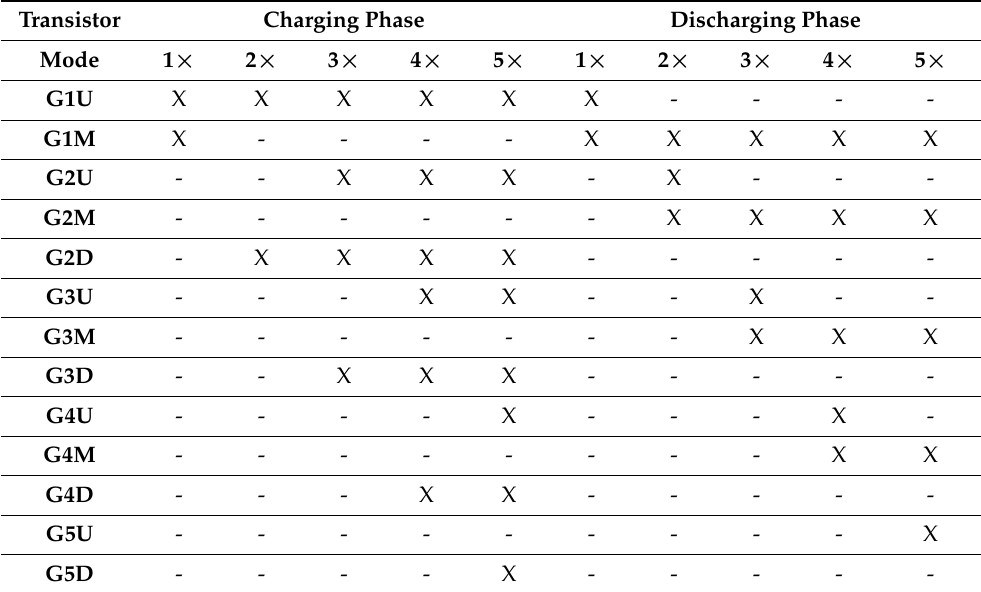
Table 2. Charge pump transistor switching states control according to the modes and phases. Transistor Charging